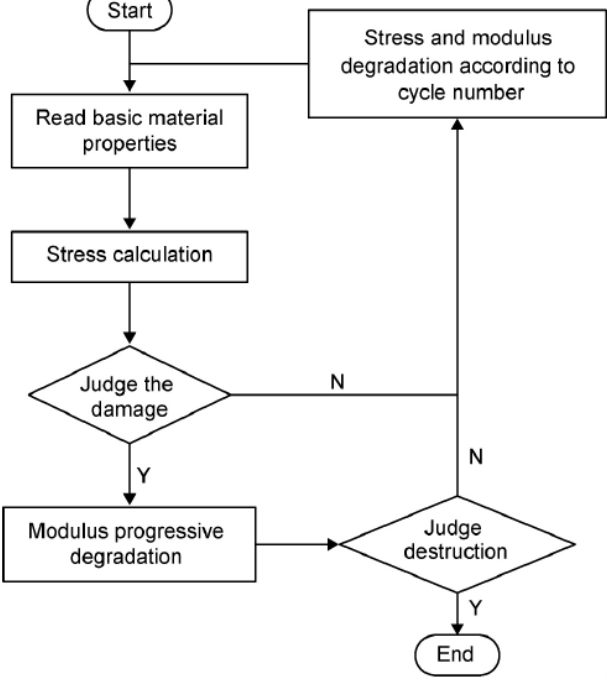
Figure 4. Flow chart of fatigue simulation.